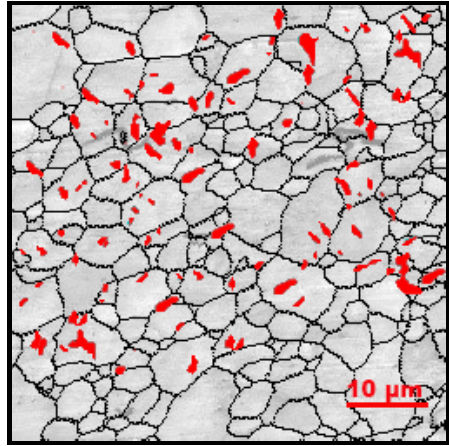
Figure 8. Room temperature tensile fractograph of M9.8 WQ sample aged at 550 °C for ( a ) 240 min and ( b ) 120 min.